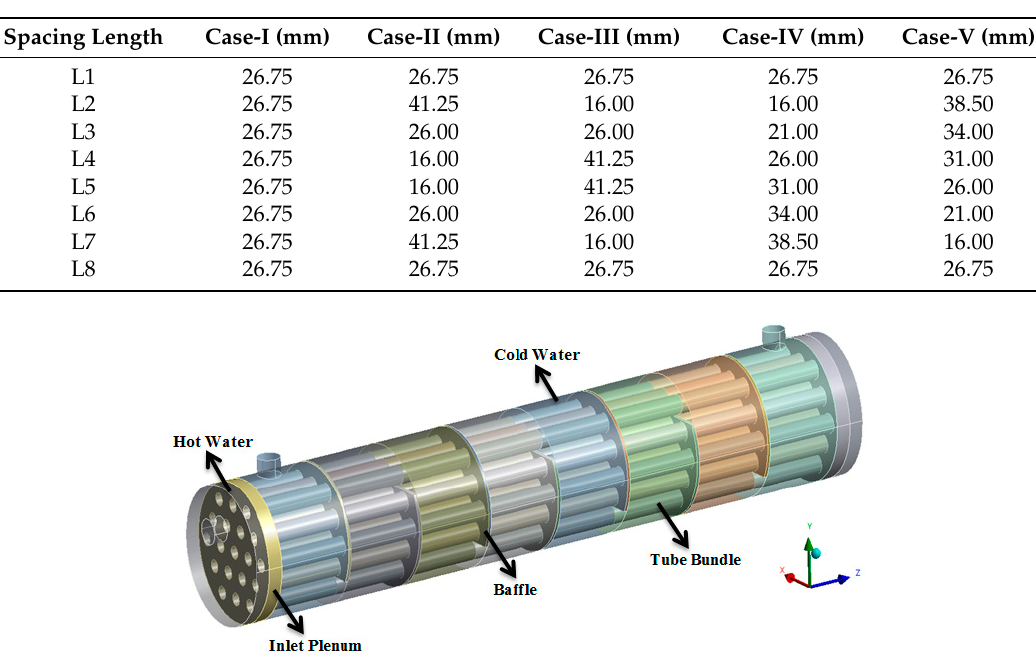
Table 1. The dimensions of baffle spacing lengths for all cases.